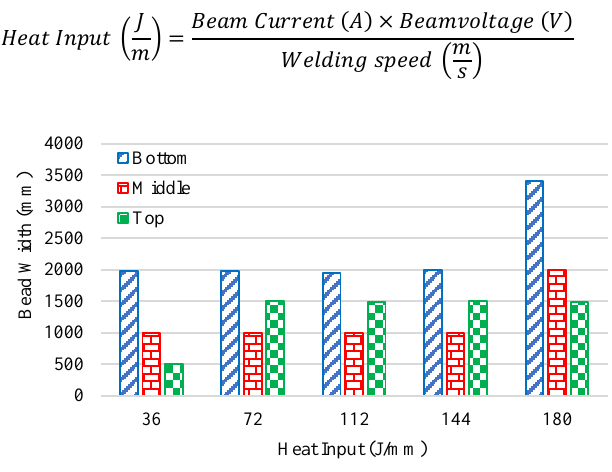
Figure 2: Weld Width versus Heat Input